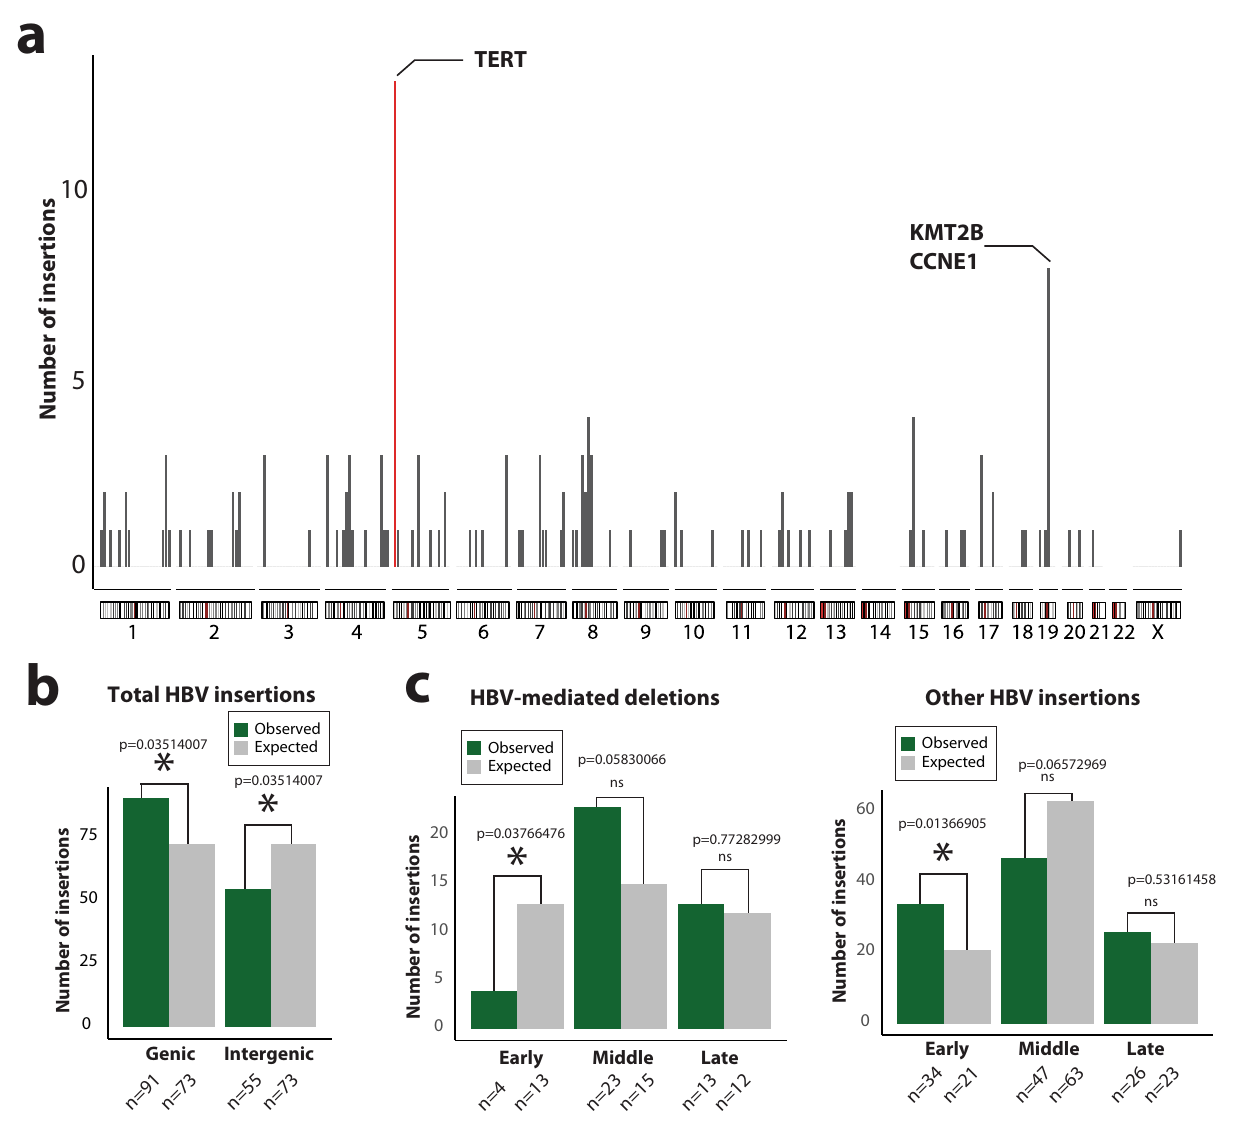
Fig. 4 Distribution of HBV insertions across the HCC genome and association with genomic organisation features. a Bars show the number of HBV insertions per 10-Mb window of the genome. Red bar represents the TERT hotspot at chromosome 5p. Other genes ( KMT2B and CCNE1 ) with high rate of HBV insertion are shown at chromosome 19q. b HBV insertions are more frequent in genes than expected by chance ( χ 2 test, P = 0.0035, n = 91) and depleted in intergenic regions of the genome ( χ 2 test, P = 0.035, n = 55). False Discovery Rate “ FDR ” correction was applied (see Methods). c HBV events at telomeric deletion breakpoints are depleted in regions of the genome exhibiting early replication timing ( χ 2 test, P = 0.037, n = 4), while the remaining HBV insertions show the opposite pattern ( χ 2 test, P = 0.013, n = 34). “ ns ” stands for not signi fi cant. FDR correction was